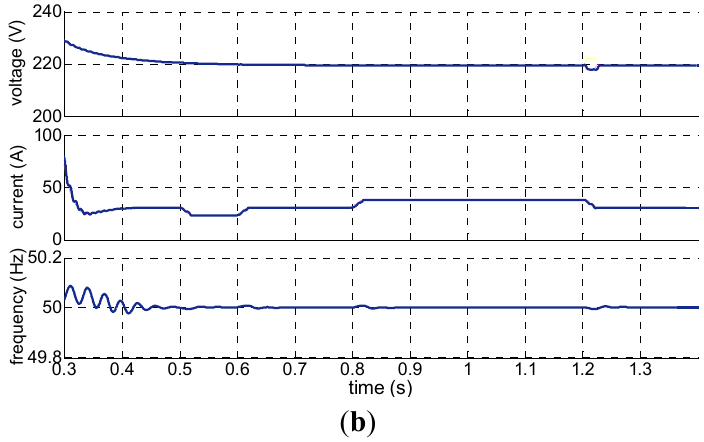
Figure 12. The effect of V/f control on the storage battery: ( a ) Active and reactive output power of the storage battery; ( b ) The phase voltage, line current and frequency output from the storage